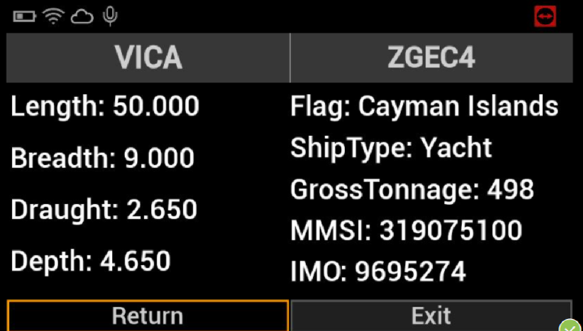
Figure 8. Static information shown by the smart glasses.